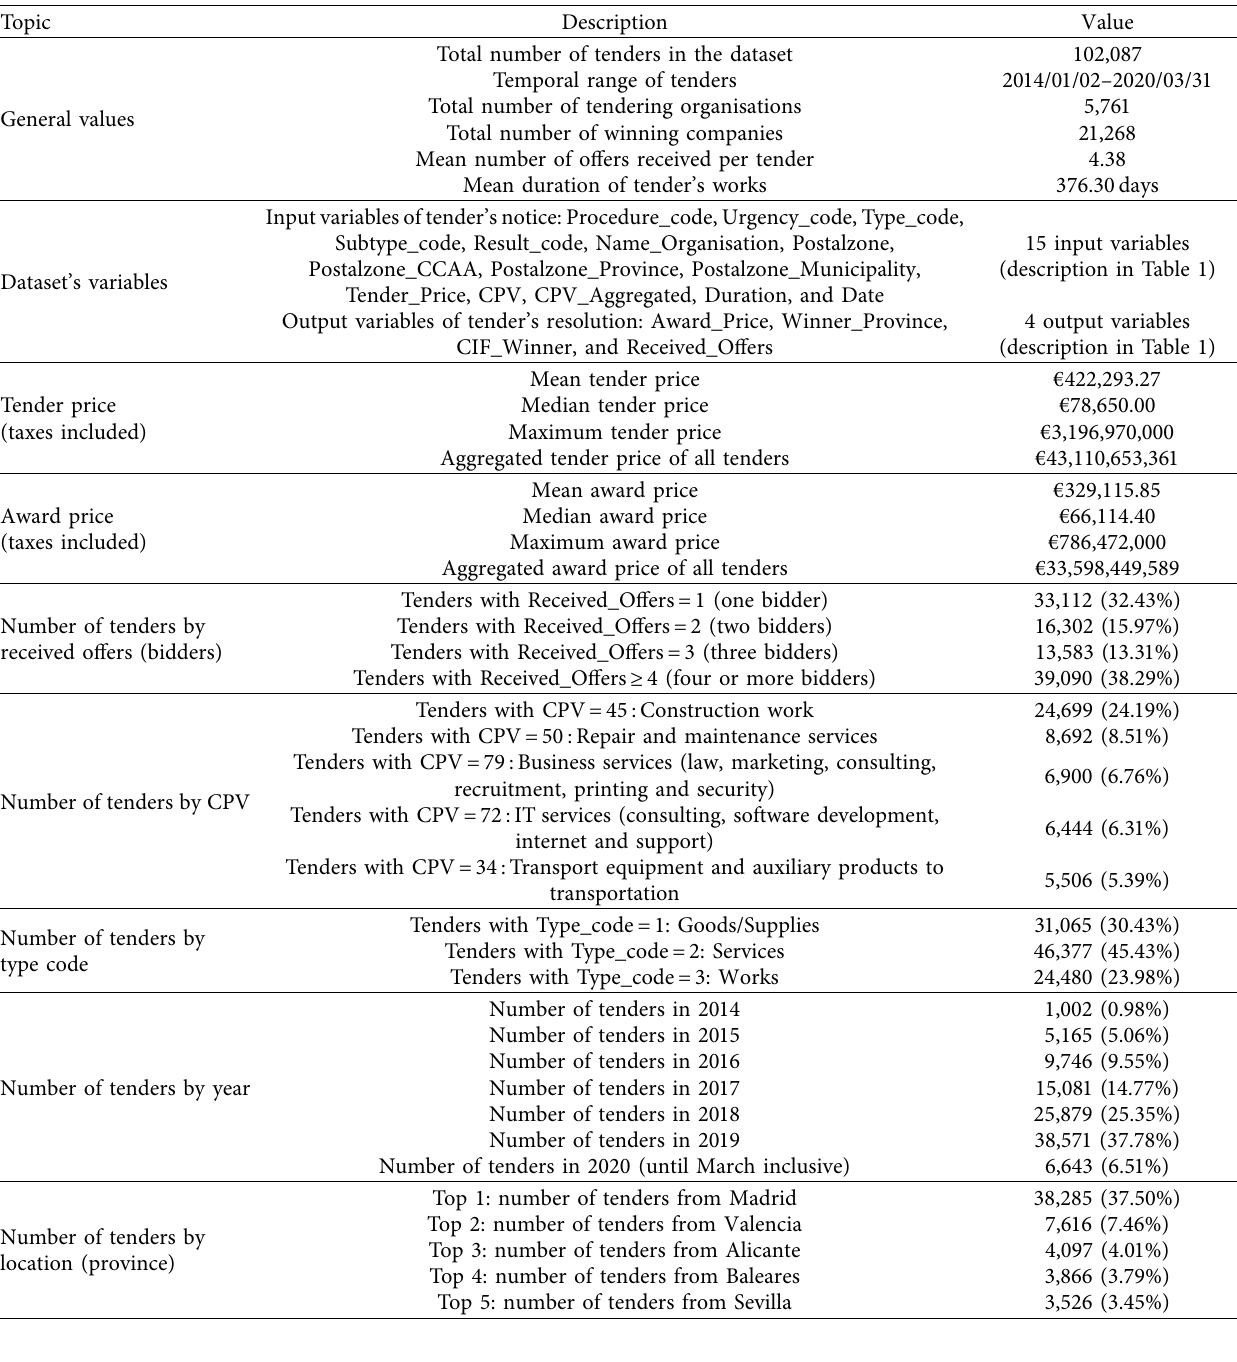
Top 1: number of tenders from Madrid Top 4: number of tenders from Baleares Top 5: number of tenders from